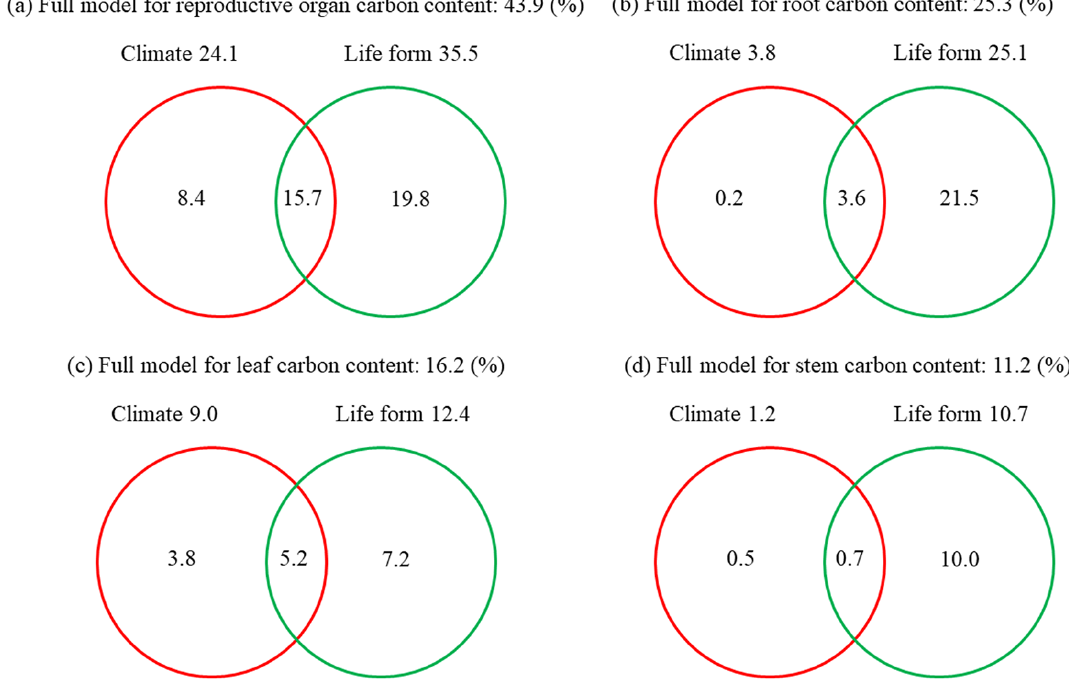
Figure 4. Variation partitioning ( r 2 ) of climate and life forms to account for the variation in plant carbon contents across different organs. (a) Reproductive organ, (b) root, (c) leaf, and (d) stem. Life form independently explained more variation of carbon content in each organ than climate.